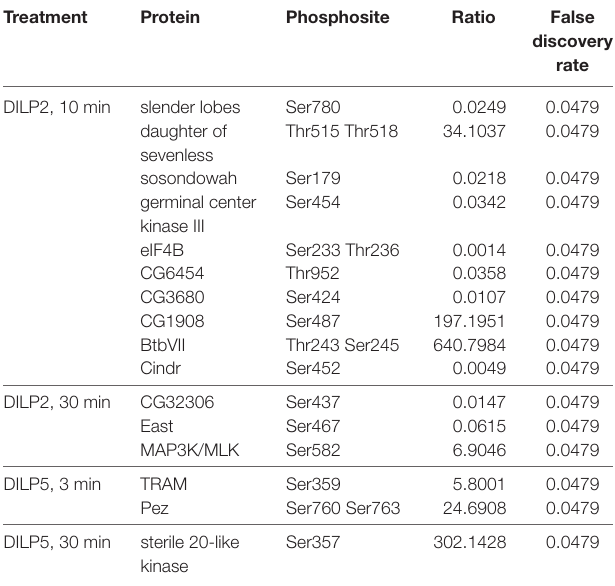
TaBle 2 | Significantly altered phosphosites stimulated by Drosophila insulin-like peptide (DILP) 2 and DILP5. Treatment Protein Phosphosite ratio False